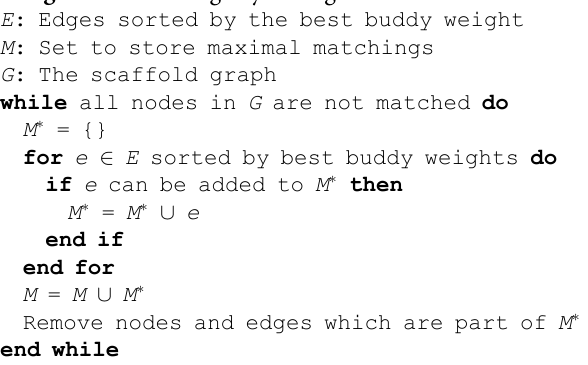
Algorithm 1 Contig Layout